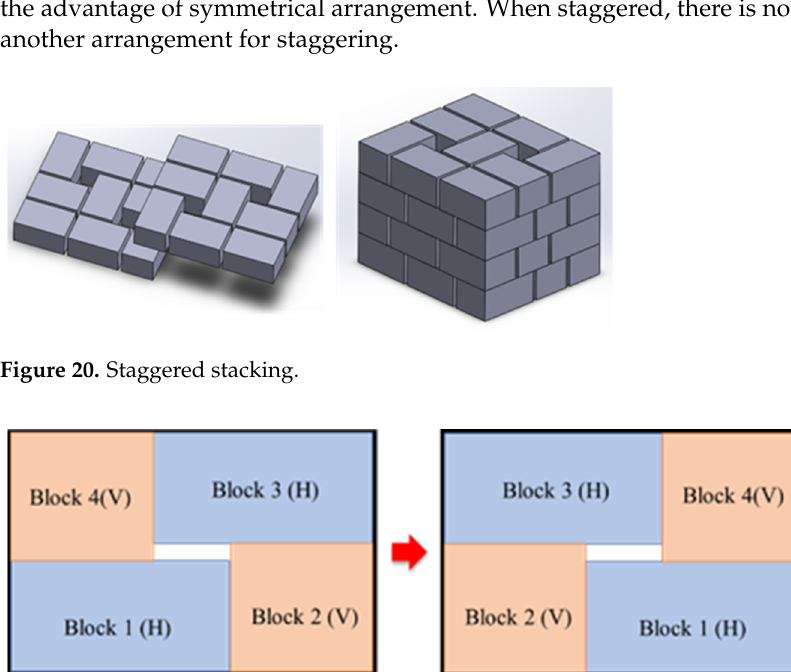
Figure 19. Vertical overlap object mark.